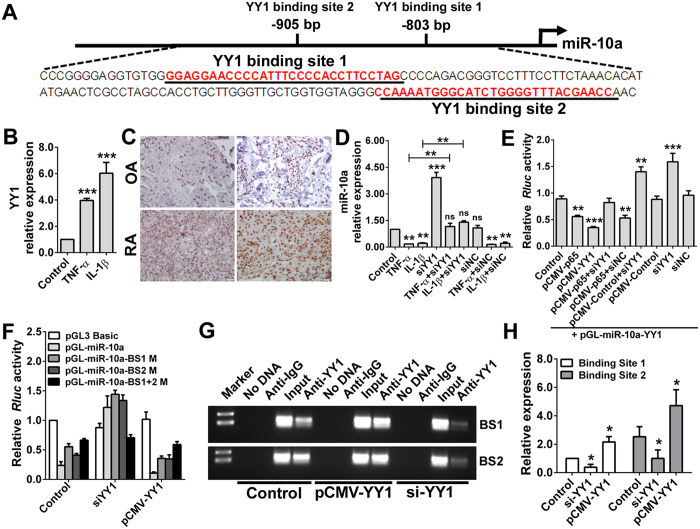
miR-10a is directly downregulated by YY1.(A) Schematic diagram showing the promoter sequence of miR-10a, which contains two YY1 binding sites. (B) RA FLS (n = 3 samples) primary cells were stimulated with TNF-α or IL-1β for 24 h, and the YY1 level was detected via real-time PCR. (C) The YY1 expression level was detected in synovial tissue specimens from RA and OA patients (n = 5 samples) through immunohistochemistry. (D) RA FLSs (n = 3 samples) were treated with TNF-α or IL-1β, with or without interference with YY1 (siYY1), and the miR-10a expression level was detected via qRT-PCR. (E) HEK293T cells were transfected with a pGL-miR-10a-YY1 luciferase reporter vector constructed with the promoter region of miR-10a that contains the two YY1 binding sites, either alone or in combination with pCMV-p65, pCMV-YY1 or siYY1. Groups subjected to treatment with pGL-miR-10a-YY1 alone, scramble siRNA (siNC) or the empty vector (pCMV-control) were used as control groups. Renilla luciferase activity was measured 24 h later. (F) HEK293T cells were transfected with luciferase reporter vectors constructed with the miR-10a promoter region containing mutations in YY1 binding site 1 (pGL-miR-10a-BS1 M) or binding site 2 (pGL-miR-10a-BS2 M), or in both sites (pGL-miR-10a-BS1+2 M), and luciferase activity was measured 24 h later. (G) HEK293T cells were transfected with pCMV-YY1 or siYY1 to increase or reduce YY1 levels, and a ChIP assay was used to detect the direct binding of YY1 to the miR-10a promoter. (H) Statistical analysis of (G). nsP > 0.05,*P < 0.05, **P < 0.01 or ***P < 0.001 compared with the control group. Data are representative of three experiments.